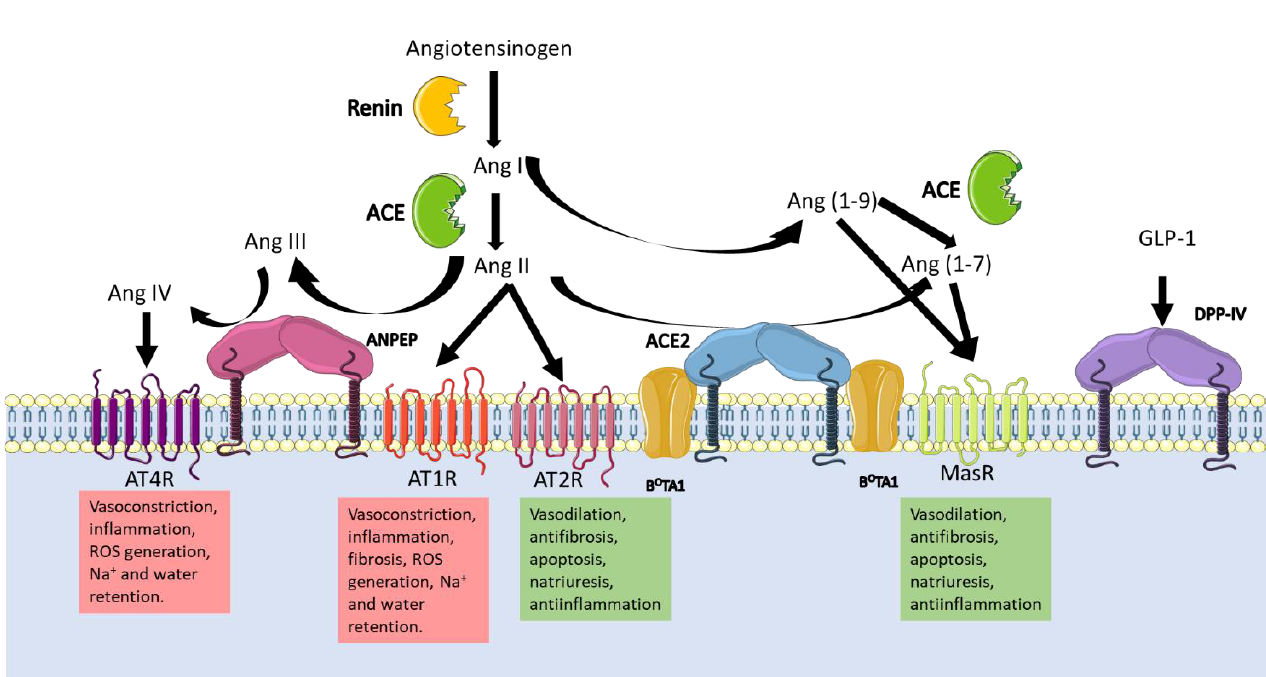
Figure 3. Schematic representation of the peptide flux involved in the RAAS highlighting the participation of the viral receptors ANPEP, DPP-IV, and ACE2. When hypotension is detected, the Angiotensinogen produced in the liver, is catalyzed by the enzyme renin synthetized in the juxtaglomerular cells in the kidney. The product Ang I is either cleaved by the ACE to produce Ang II, which activates any of the Ang II receptors (AT1R and AT2R). Ang I and Ang II can be also cleaved by ACE2 to produce Ang (1-9) and Ang (1-7), respectively. The additional cleavage of ACE to Ang (1-9) produces Ang (1-7) which finally activates the MasR. Additionally, Ang II can be further catalyzed twice by ANPEP producing Ang IV, which activates the AT4R. The effects every Ang II Receptor has, counteracts others so the accurate balance is necessary in order to control blood pressure, osmolarity and inflammation. Ang II is also necessary for aldosterone secretion, which reabsorbs sodium in the kidney, and the antidiuretic hormone release which retains water. The overall effect of the system is the increase of blood pressure. The blockage of the enzymes either with coronaviruses or with other molecules, alters the homeostasis of blood pressure and osmolarity.